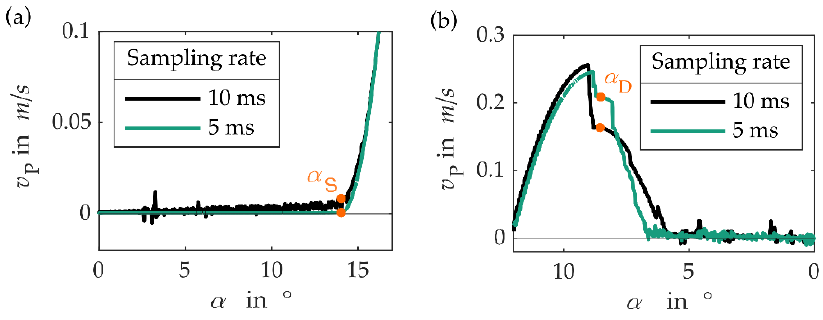
Figure 7. (a) Results of the static friction scenario; (b) results of the dynamic friction scenario.